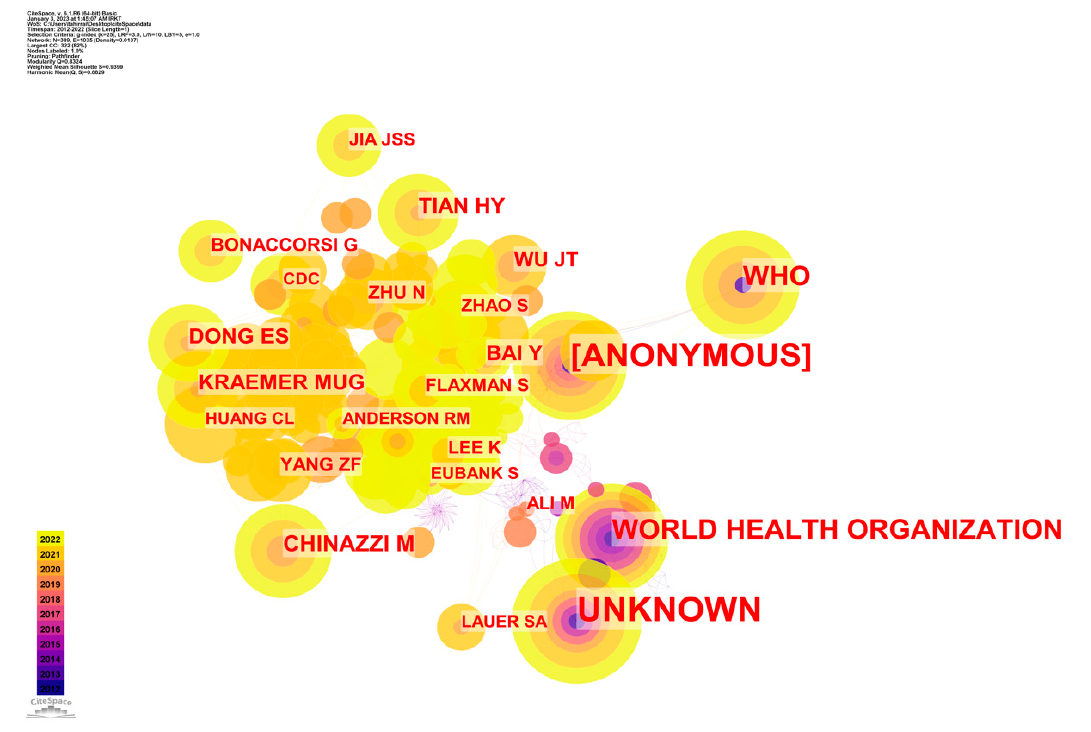
Figure 9. CS map of co-citation author analysis of studies of epidemic control based on big data research.